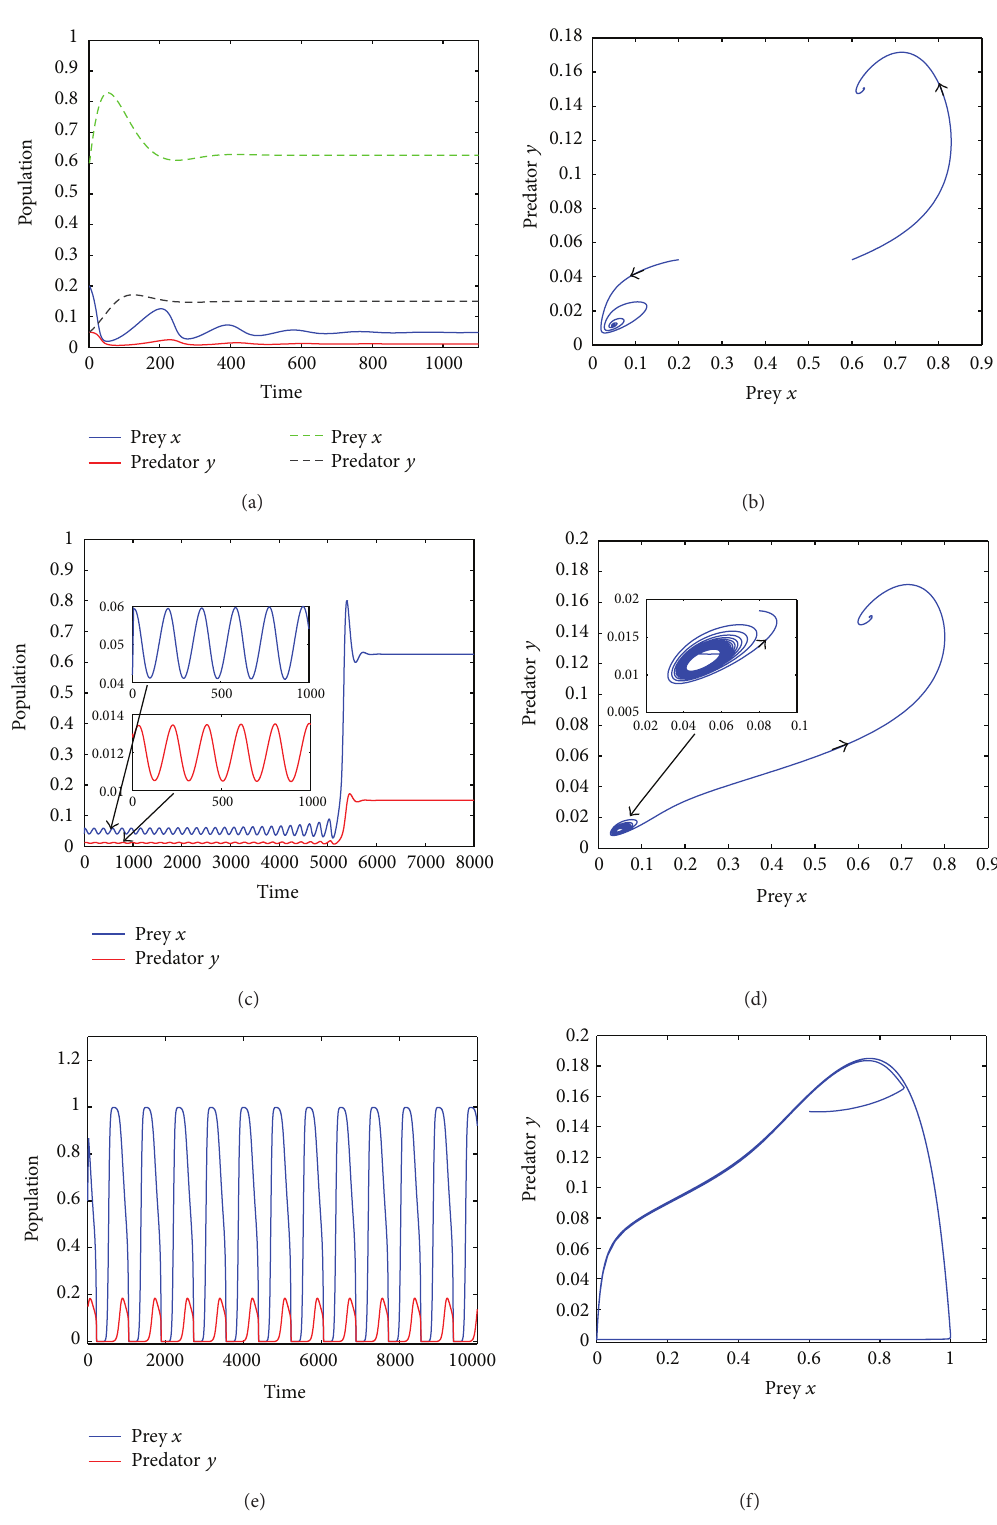
Figure 9: The trajectory graphs and phase portrait of system (6) for (𝛼, 𝛽) ∈ 𝐷 3 with 𝛼 = 0.01 , 𝛽 = 0.24 , and 𝛾 = 0.5 . (a)-(b) When 𝐸 ∗ 𝜏 = 0 , the positive equilibria 𝐸 ∗ 1 and 3 are both asymptotically stable. The initial values are , 𝜏 } , the positive equilibria 𝐸 ∗ 𝐸 ∗ 0.37 < min {𝜏 01 03 1 and 3 are both asymptotically stable and there exists a subcritical Hopf bifurcation near Here, the initial values is (0.042, 0.013) . (e)-(f) When 𝜏 = 2.5 > max {𝜏 01 ,𝜏 03 } . All of the three equilibria become unstable and there exists a large-amplitude stable periodic orbit enclosing the three equilibria. Here, the initial value is (0.6, 0.15)